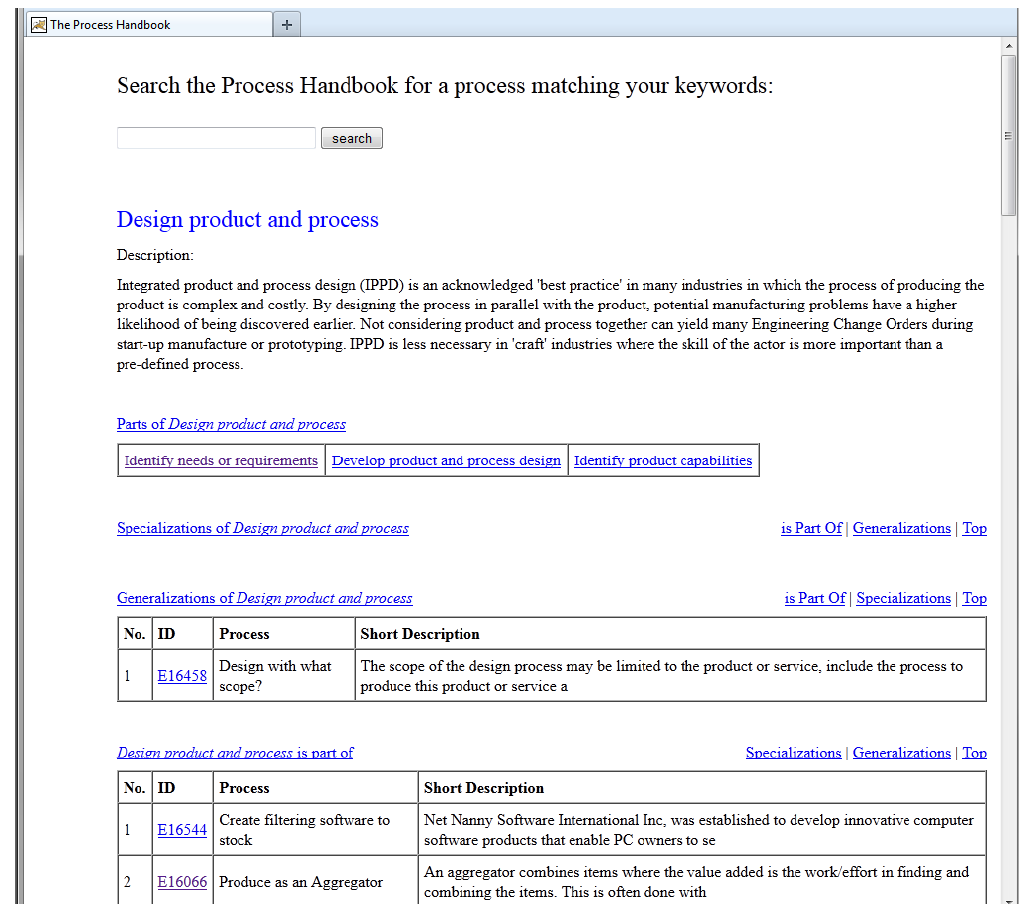
Figure 9. Detailed information and navigation instruments of the